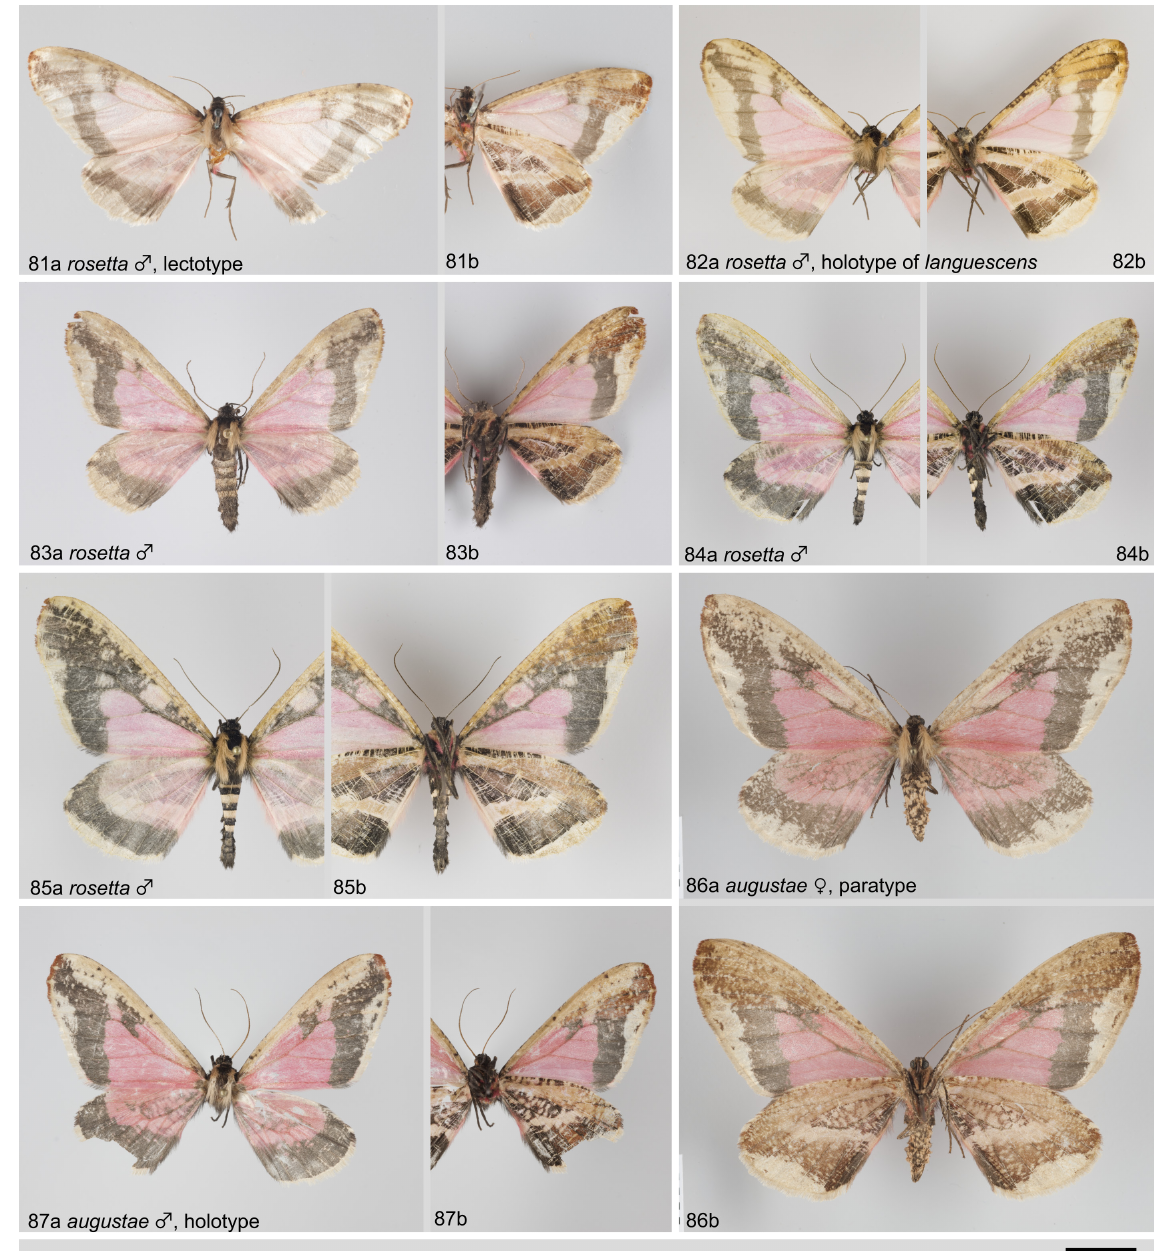
Figs 81–87. Adult moths (a = dorsal view; b = ventral view). 81 . Callipia rosetta Thierry-Mieg, 1904, ♂, lectotype (C-0290). 82 . C. rosetta Thierry-Mieg, 1904, ♂, holotype of languescens Warren, 1904 (NHM). 83 . C. rosetta Thierry-Mieg, 1904, ♂ (C-0011, COI data). 84 . C. rosetta Thierry-Mieg, 1904, ♂ (ID 22359, COI data). 85 . C. rosetta Thierry-Mieg, 1904, ♂ (ID 22362, COI data). 86 . C. augustae sp. nov., ♀, paratype (C-0432). 87 . C. augustae sp. nov., ♂, holotype (C-0056, COI